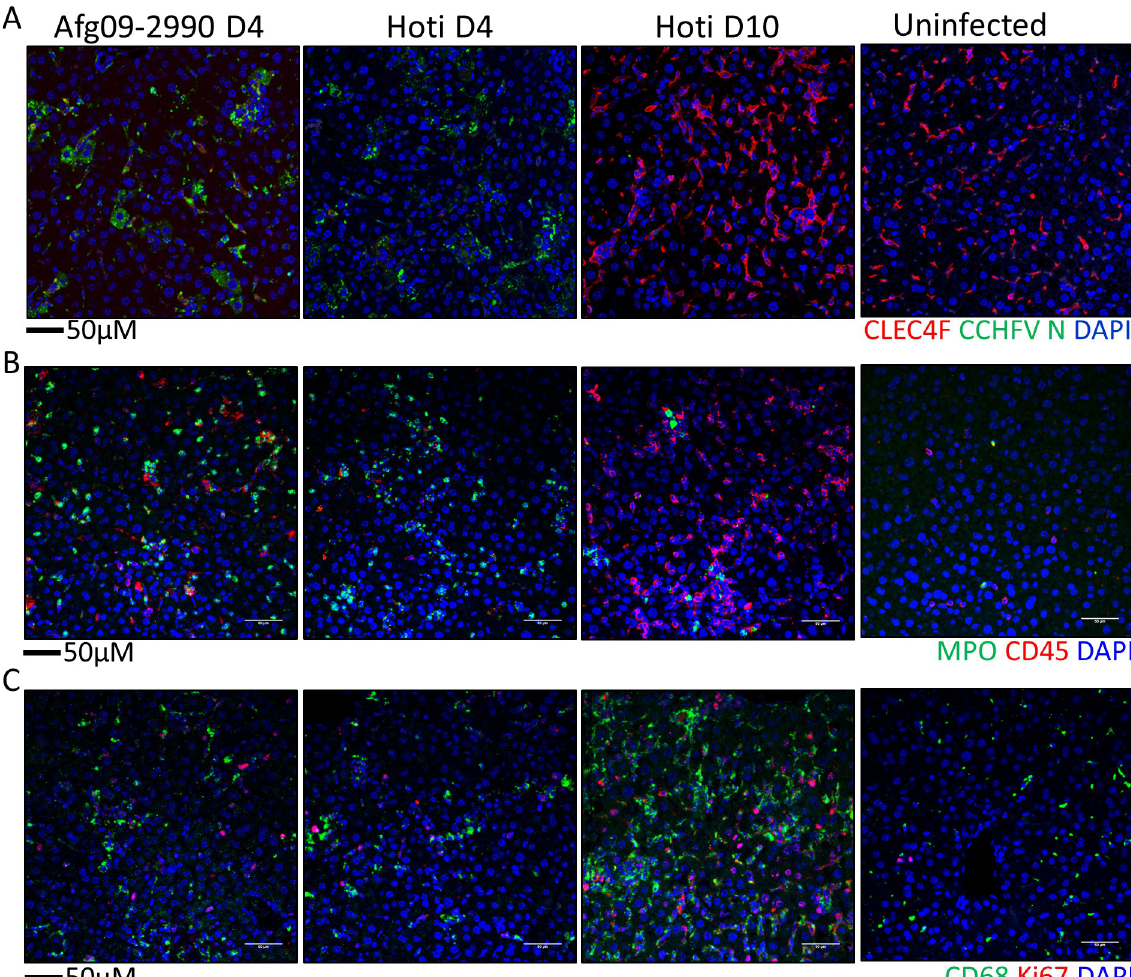
Fig 9. Immune cell levels in Hoti and Afg09-2990 infected mice. A. Liver sections from day 4 Afg09-2990 or Hoti infected or uninfected mice were stained with anti-CLEC4F (red) and anti-CCHFV N protein (green) antibodies. B. Liver sections from were stained with MPO (green) and CD45 (red). C. IFA demonstrating presence of CD68 + macrophages (green) and Ki67 + proliferating cells (red) in livers of day 4 animals. For all panels, cell nuclei were stained with